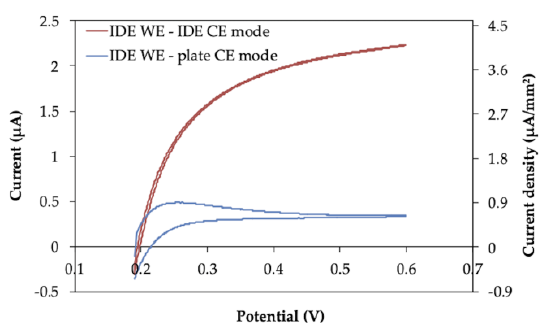
Figure 2. Cyclic voltammograms of IDE strip. Each cyclic voltammogram was obtained in the solution containing both 1 mM ferrocyanide and 9 mM ferricyanide, as a total concentration of 10 mM ferrocyanide/ferricyanide. Cyclic voltammogram in red was obtained using IDE with IDE WE - IDE CE mode, and the one in blue was obtained using IDE with IDE WE - plate CE mode, in 100 mM KCl. The sweep rate was 10 mV/s.